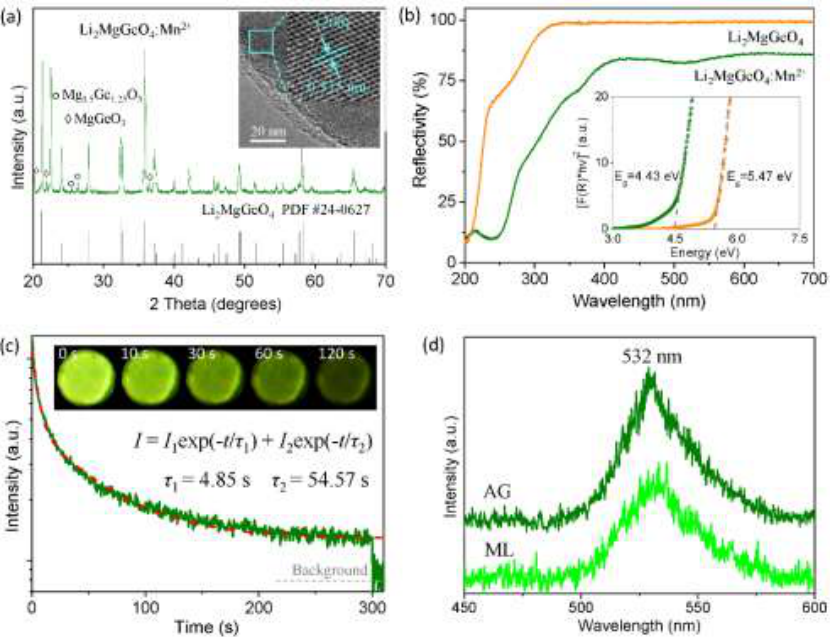
Figure 1. ( a ) XRD pattern of Li 2 MgGeO 4 :Mn 2+ powders. The inset shows the high-resolution transmission electron microscopy (HRTEM) image of an individual particle. ( b ) Diffuse reflection spectra of Li 2 MgGeO 4 and Li 2 MgGeO 4 :Mn 2+ powders. The inset plots the derived optical bandgap. ( c ) Afterglow (AG) curve of Li 2 MgGeO 4 :Mn 2+ by monitoring the emission wavelength of 532 nm. The inset presents the optical images taken at different delay times (0 – 120 s) after UV irradiation for 1 min. ( d ) AG and mechanoluminescence (ML) spectra of Li 2 MgGeO 4 :Mn 2+ .